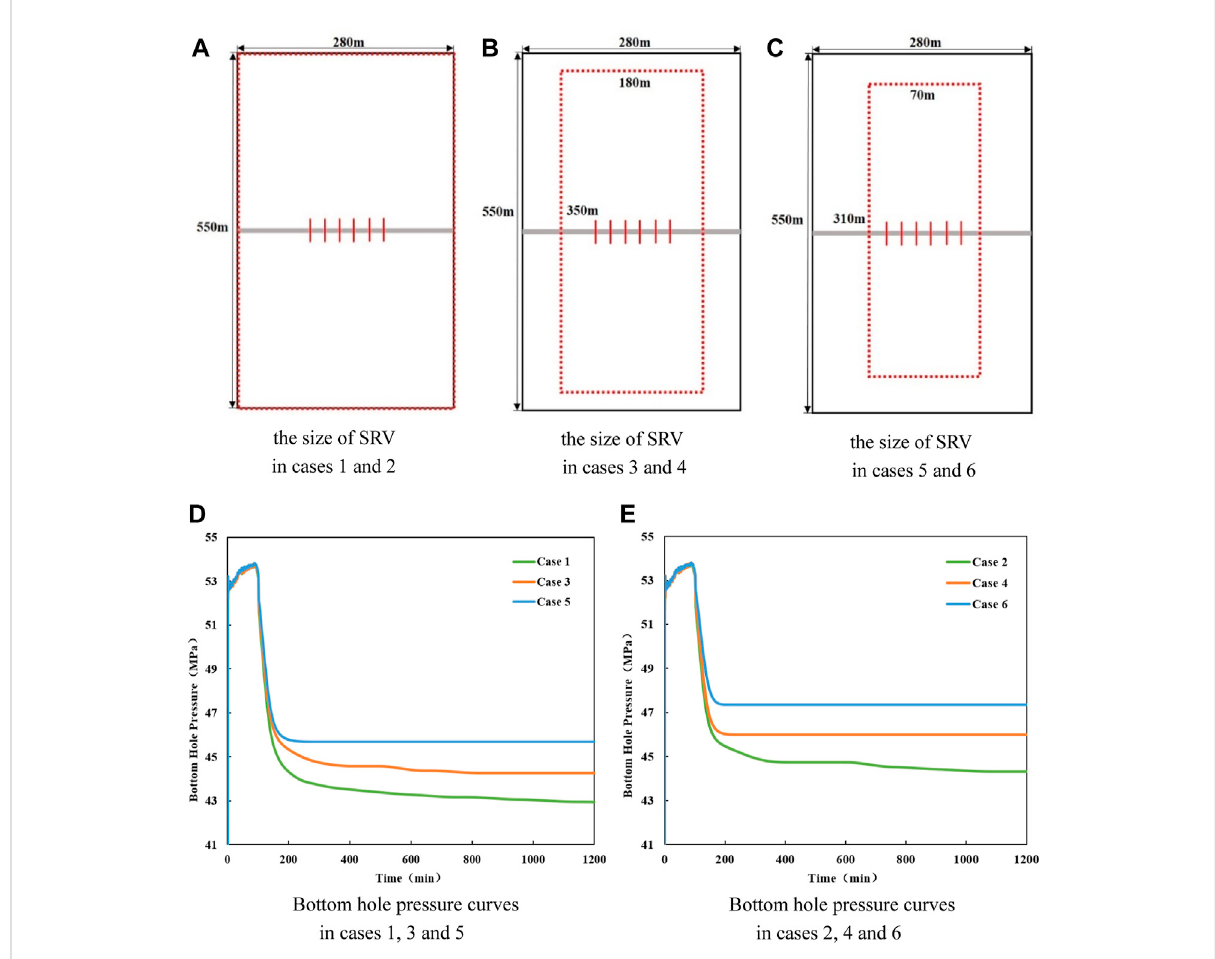
FIGURE 15 The size of SRV and bottom hole pressure curves in different cases. (A) The size of SRV in cases 1 and 2. (B) The size of SRV in cases 3 and 4. (C) The size of SRV in cases 5 and 6. (D) Bottom hole pressure curves in cases 1, 3 and 5. (E) Bottom hole pressure curves in cases 2, 4 and